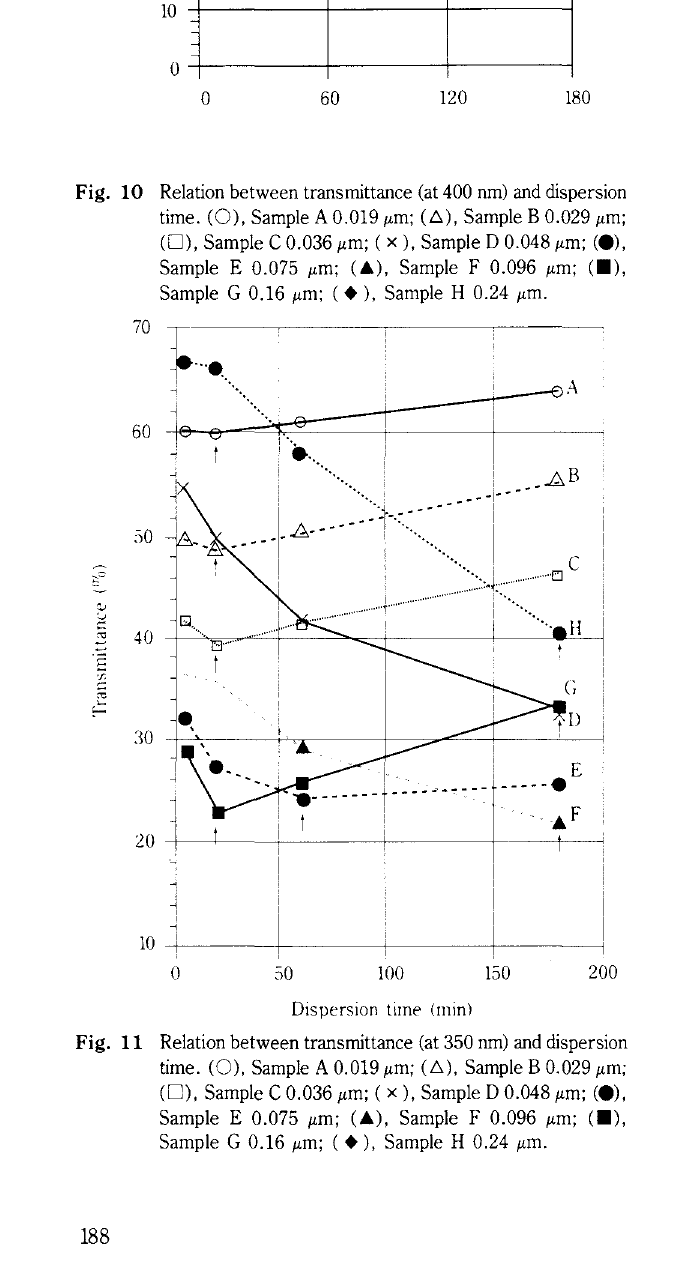
Fig. 11 Relation between transmittance (at 350 nm) and dispersion time. (0), Sample A 0.019/lm; (6), Sample B 0.029/lm; (0), Sample C 0.036/lm; ( x ), SampleD 0.048/lm; (e), Sample E 0.075 I'm; (A), Sample F 0.096 I'm; Sample G 0.16 I'm; ( + ), Sample H 0.24 flill.